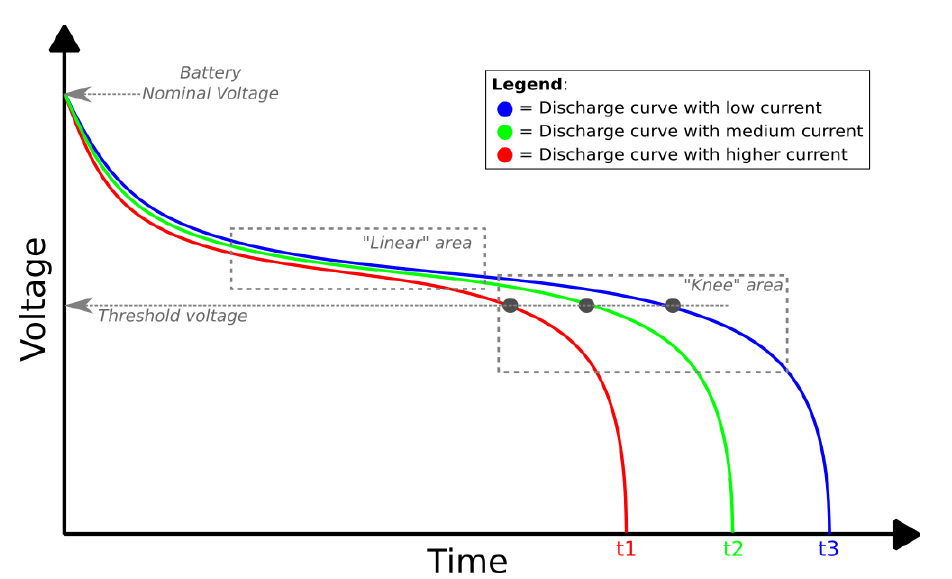
Figure 10. Example of battery discharge